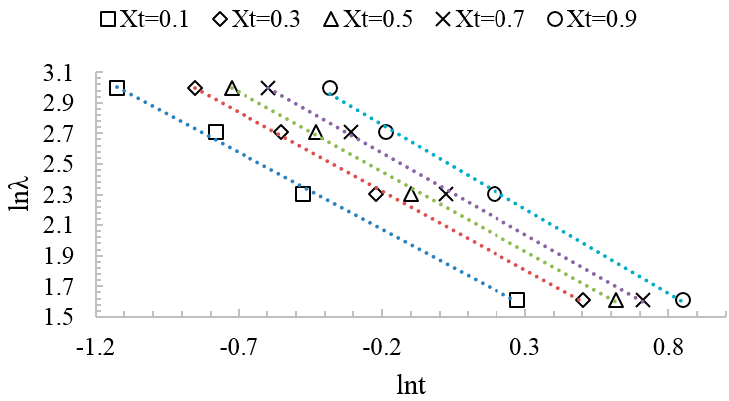
Figure 4. Plots of ln λ as a function of ln t at different X t for iPP/SDCNF10% composites based on the Liu method. Table 5. Crystallization parameters calculated from Liu method.